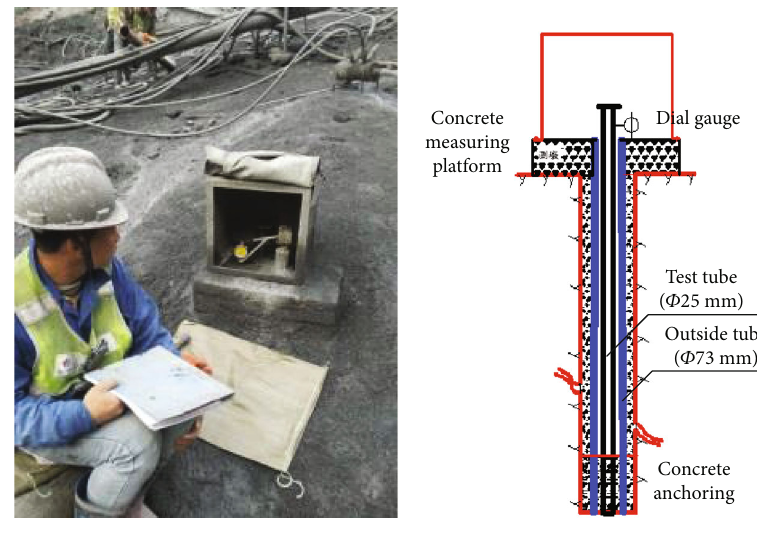
Figure 14: Field lifting monitoring.